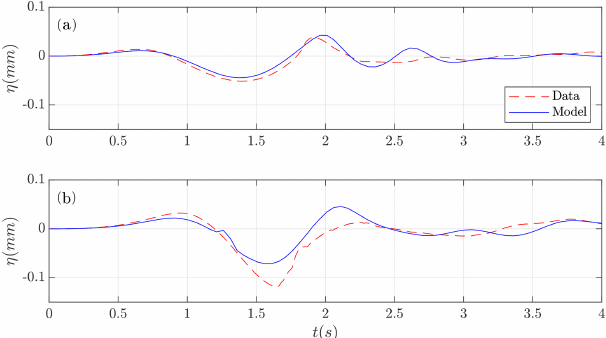
Figure 14. Submerged test case. Lab-measured water height (red) and numerical time series (blue) at wave gauges (a) WG1 and (b)